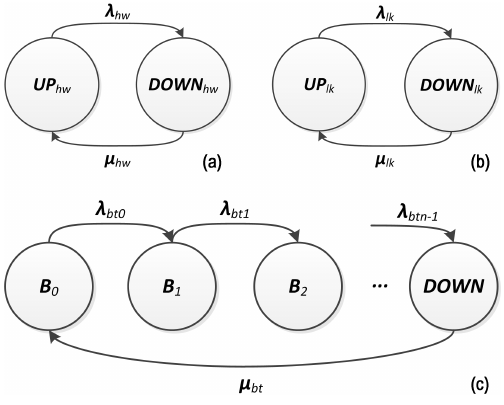
Figure 7. Markov Chain models of ( a ) hardware, ( b ) link and ( c ) battery